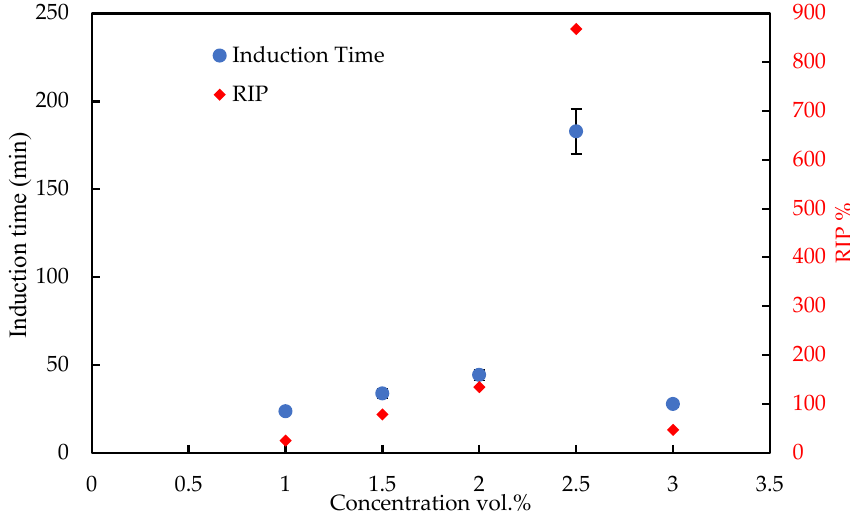
Figure 9. The effect of Tween-80 concentration on the methane hydrate induction time.